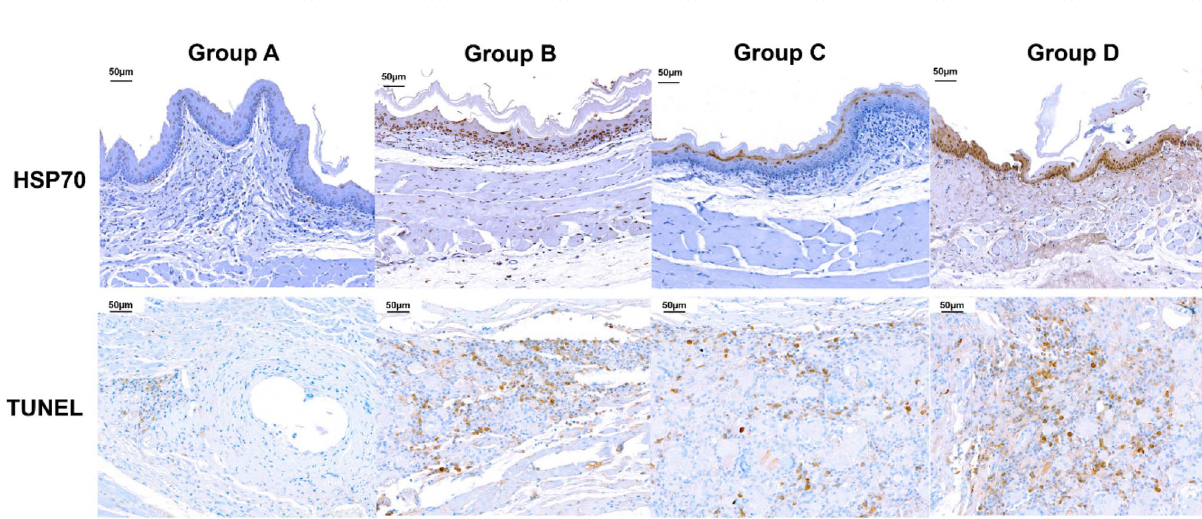
Figure 4. Representative microscopic images of immunohistochemistry sections obtained at 4 weeks (groups A and B ) and 8 weeks (groups C and D ) after stent placement. HSP70 and TUNEL expression were significantly increased in the heated groups compared to the control group (magnification, ×